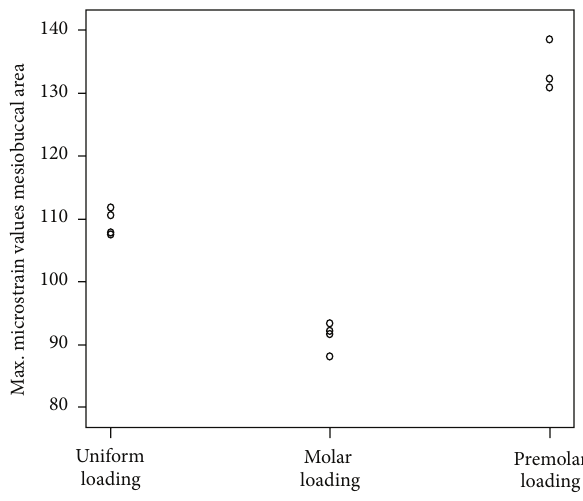
Figure 4: Maximum mean microstrain values of metal surface for all three bilateral loading conditions (left lateral mesiobuccal area).